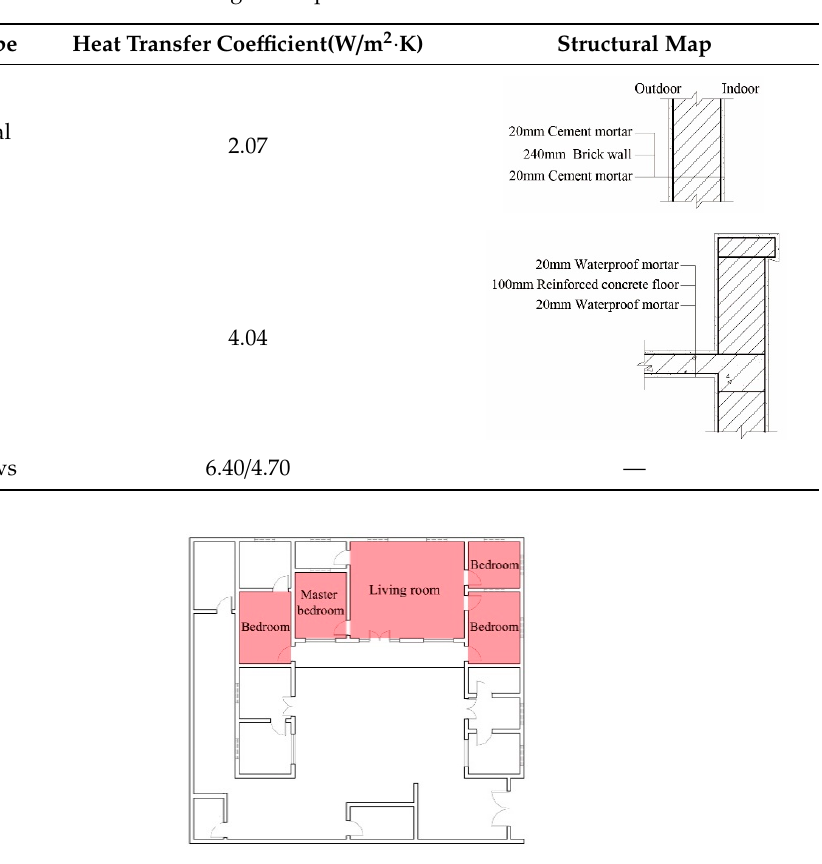
Table 3. Limit value of the heat-transfer coefficient for the rural building envelope in colder regions [29]. External Wall